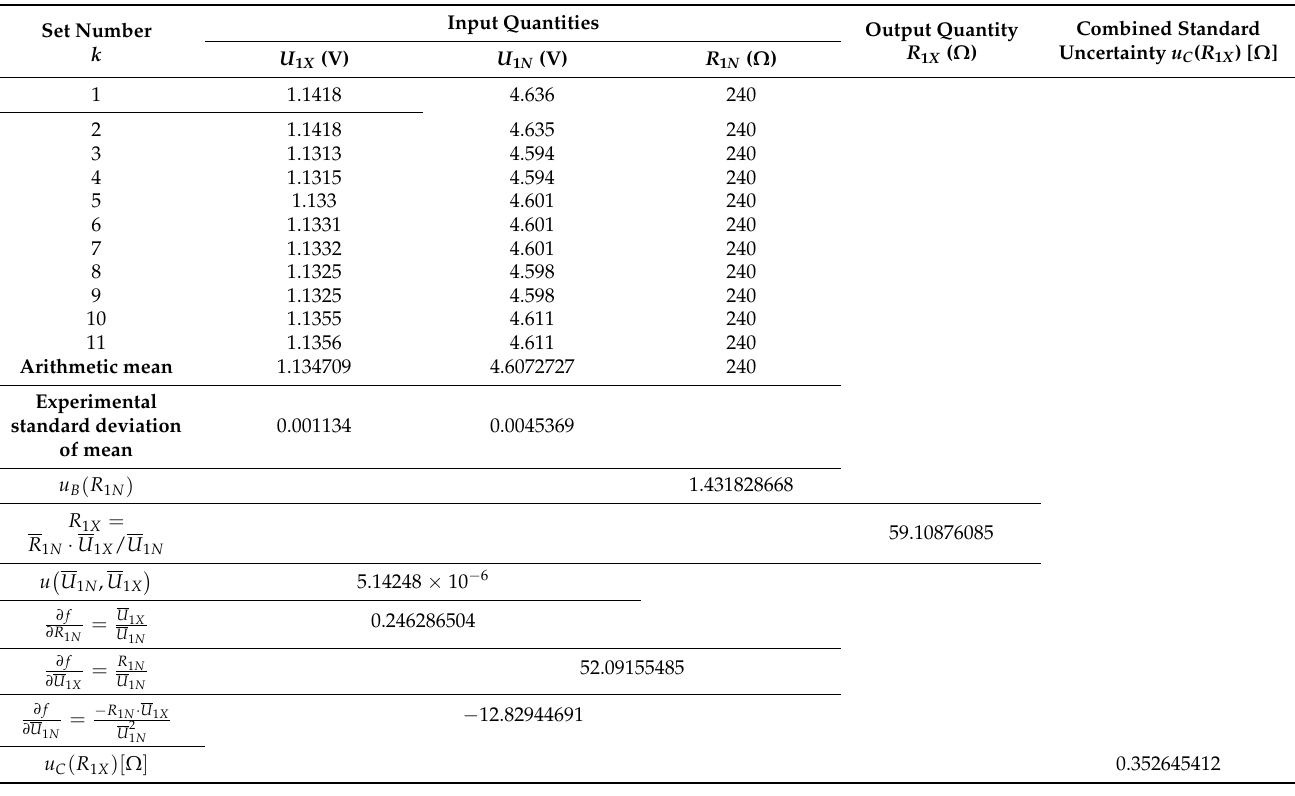
Table 3. Value of the output quantity R X and its combined uncertainty u C that were obtained according to the first approach from eleven sets of simultaneous observations.